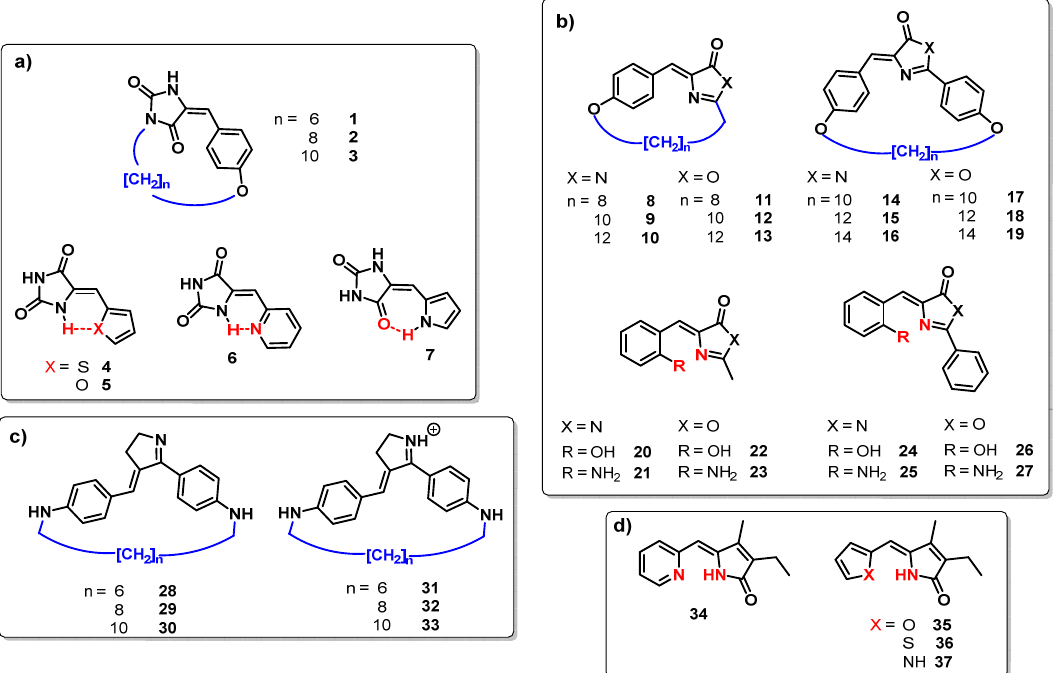
Figure 2. Computational models based on ( a ) hydantoin, ( b ) oxazolone, ( c ) rhodopsin and ( d ) aryl-idene-pyrrolinone.